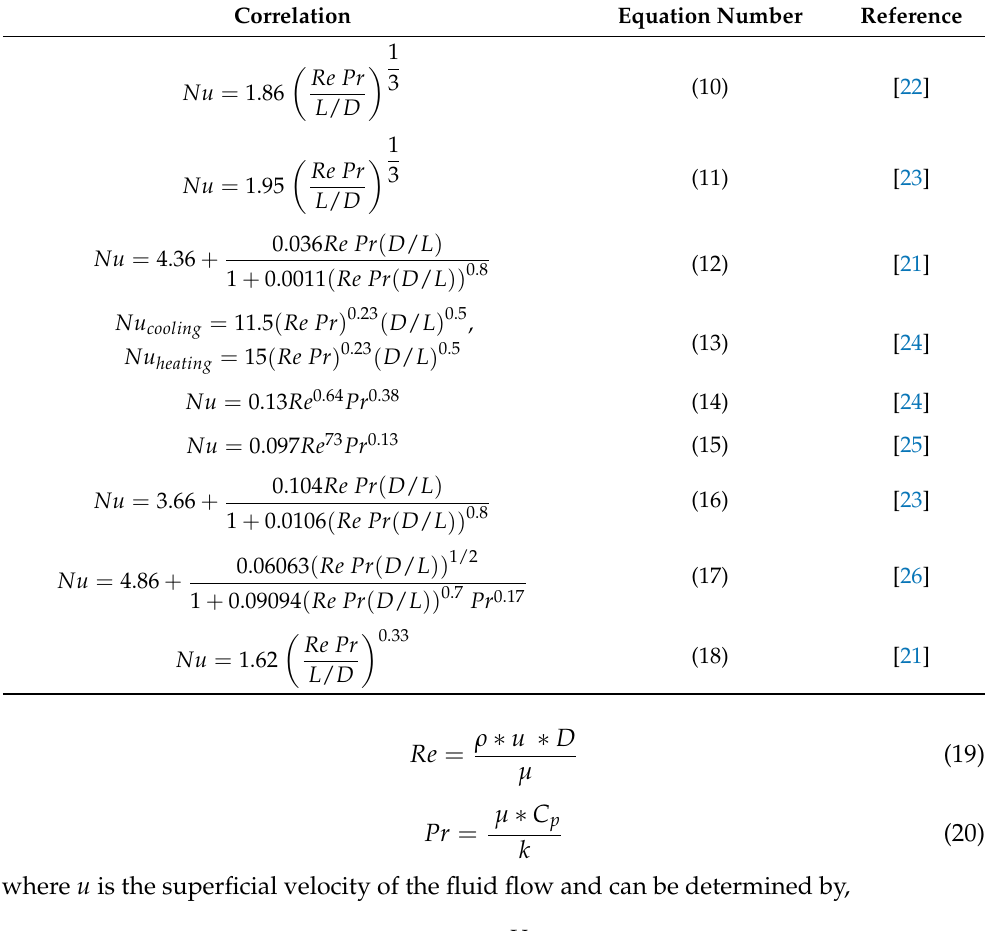
Table 1. Different types of heat transfer correlation with Reynolds number in laminar flow range. Correlation Equation Number